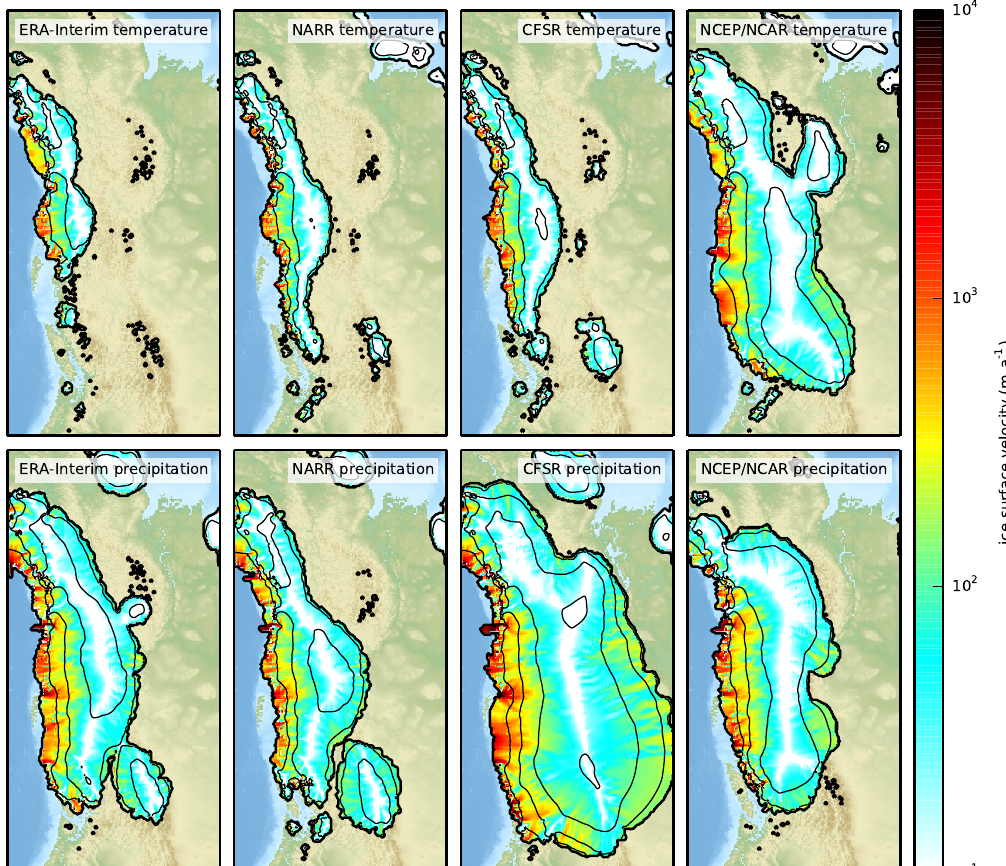
Figure 13. Ice surface topography (1km contours) and velocity (myr − 1 ) after 10kyr using “hybrid” climate forcing with precipitation rate from WorldClim and surface air temperature from each reanalysis (upper row), and surface air temperature from WorldClim and precipitation rate from each reanalysis (lower row). In other words, the upper row shows the effect of temperature anomalies, and the lower row the effect of precipitation anomalies, for each reanalysis, relative to WorldClim data. Each simulation uses a − 5 ◦ C offset for comparison with Fig. 7.